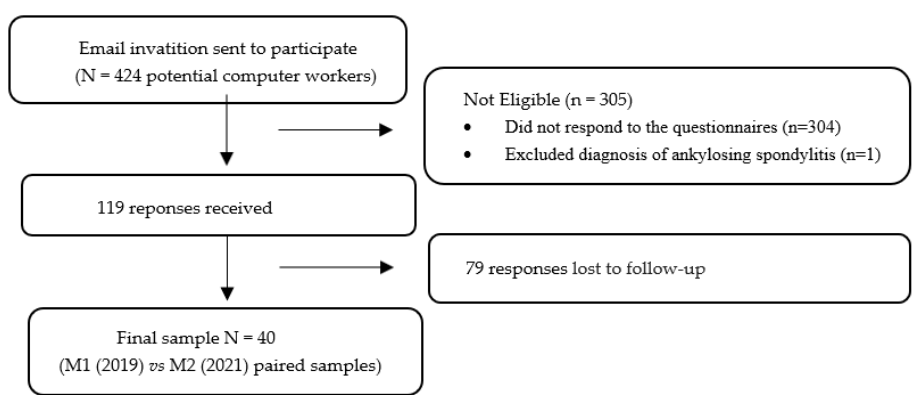
Figure 1. Flow diagram of the recruitment process.